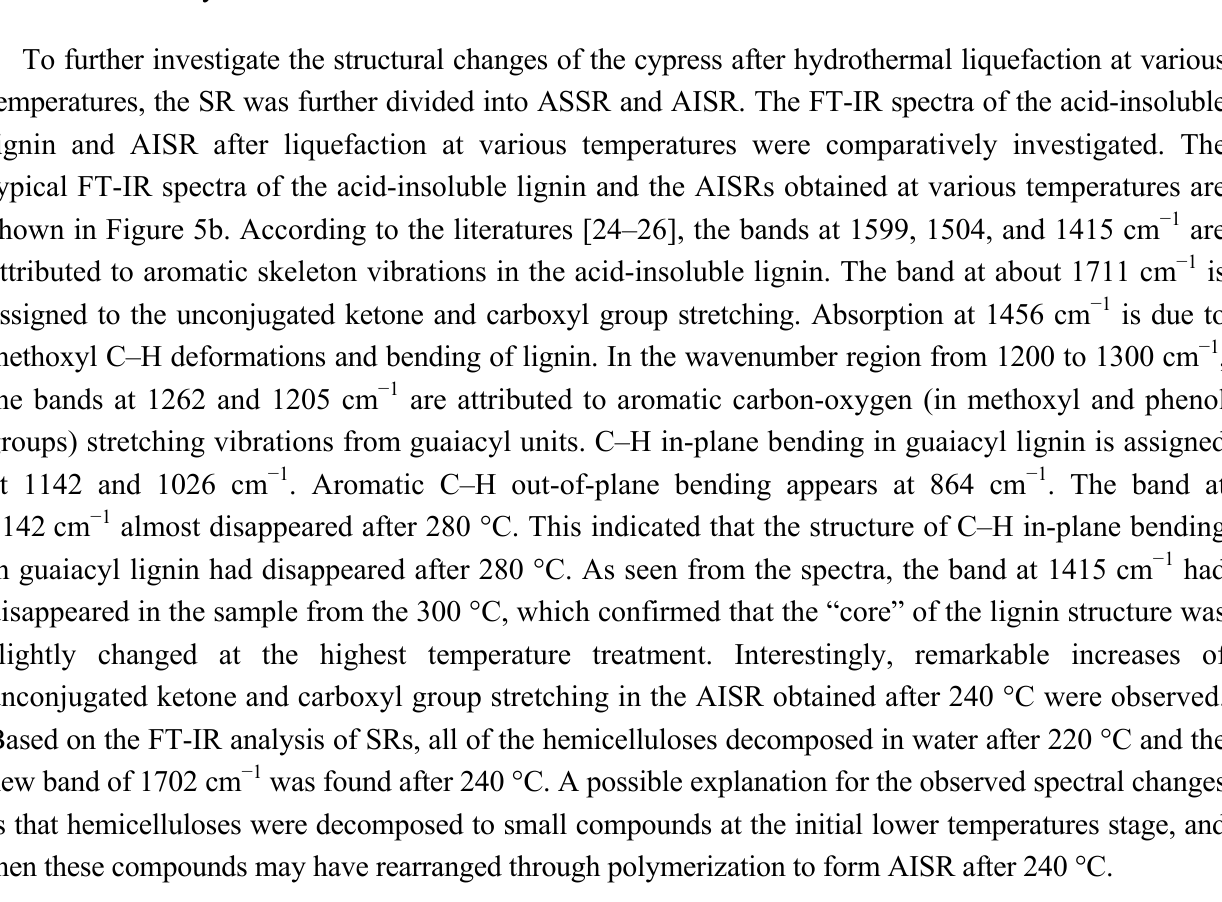
Figure 5. FT-IR analysis of the ( a ) solid residue and ( b ) acid-insoluble solid